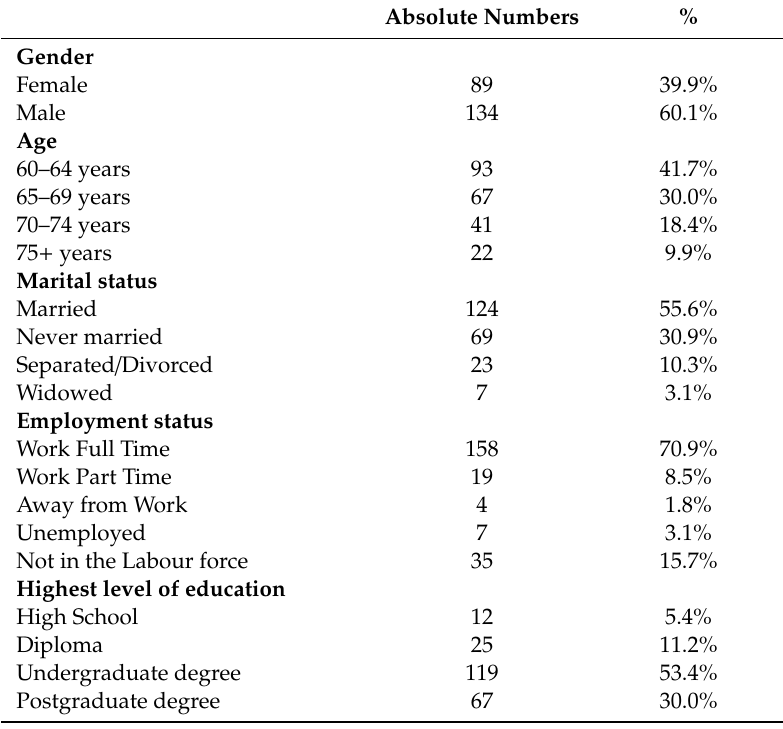
Table 1. Demographic profile of the respondents (n = 223) (Source: Authors’